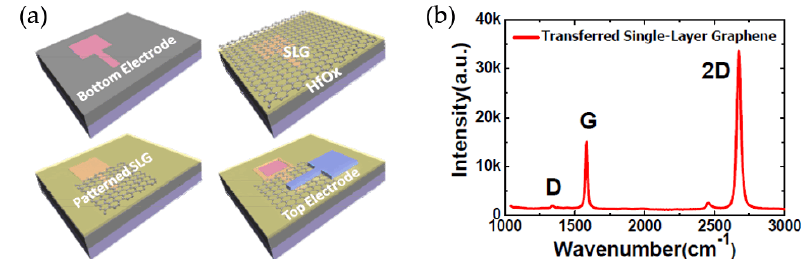
Figure 10. ( a ) Fabrication process of HfO x -based RRAM device with single-layer graphene (SLG) interlayer and ( b ) Raman spectroscopy data of transferred SLG layer [152].